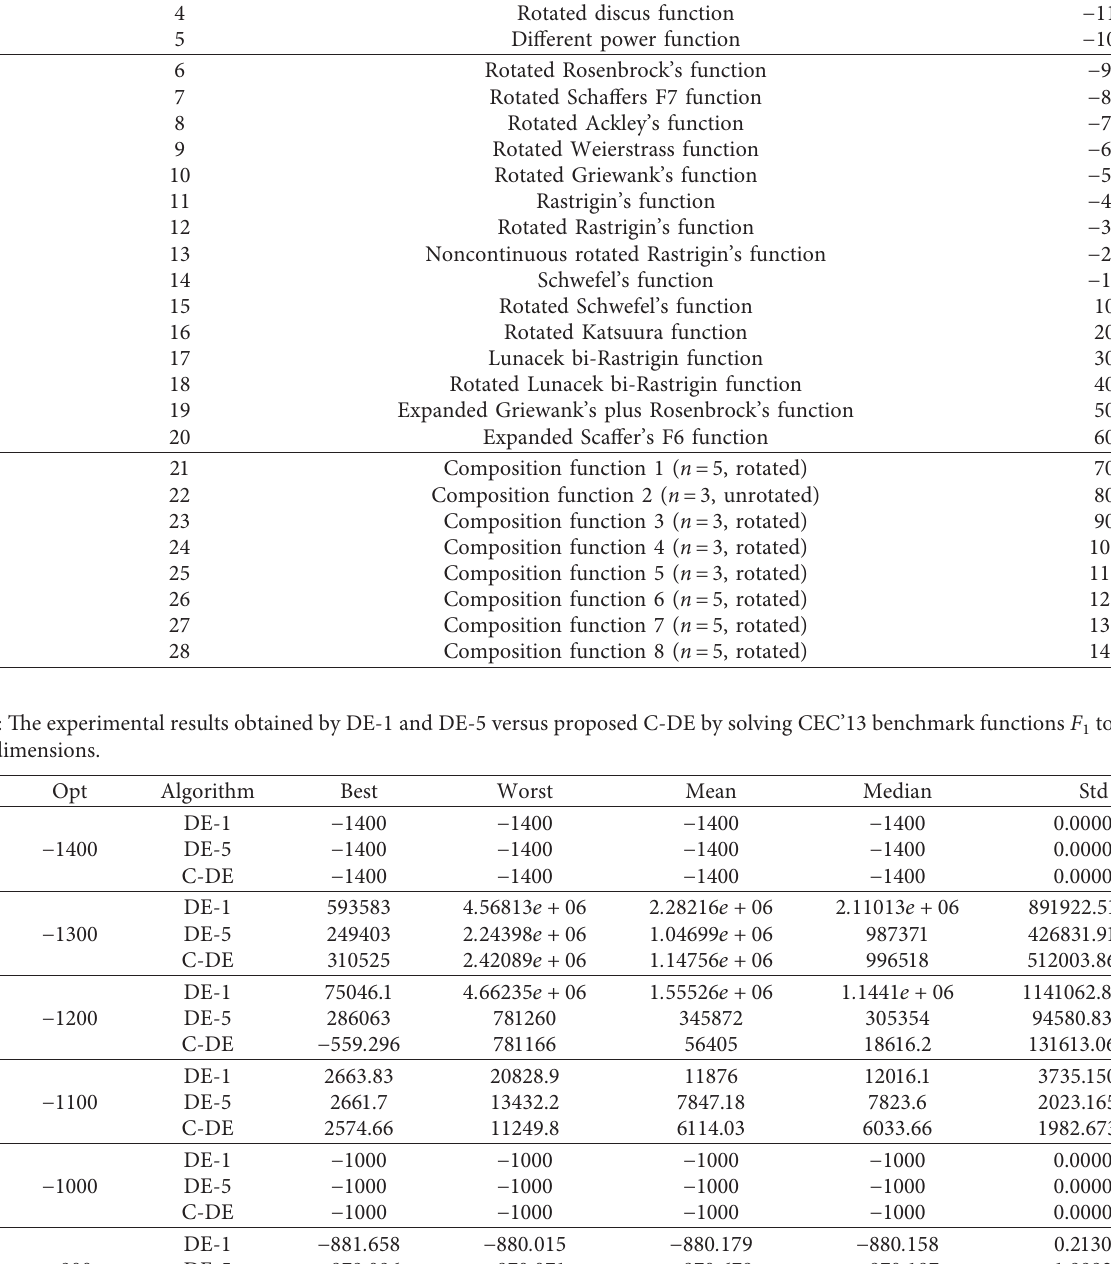
Table 1: The characteristics of the CEC’13 test function [63].